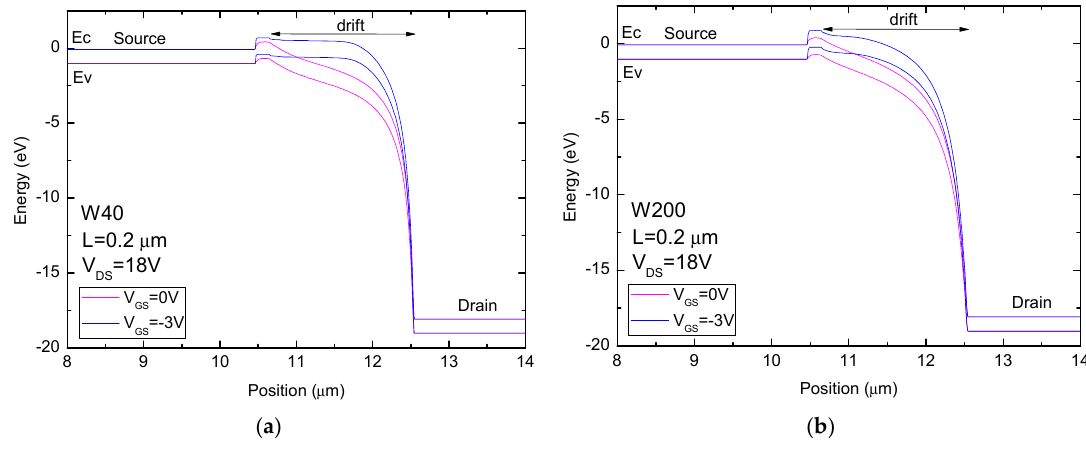
Figure 5. Longitudinal energy band diagrams of ( a ) W40 and ( b ) W200 with V GS = 0 and − 3 V.